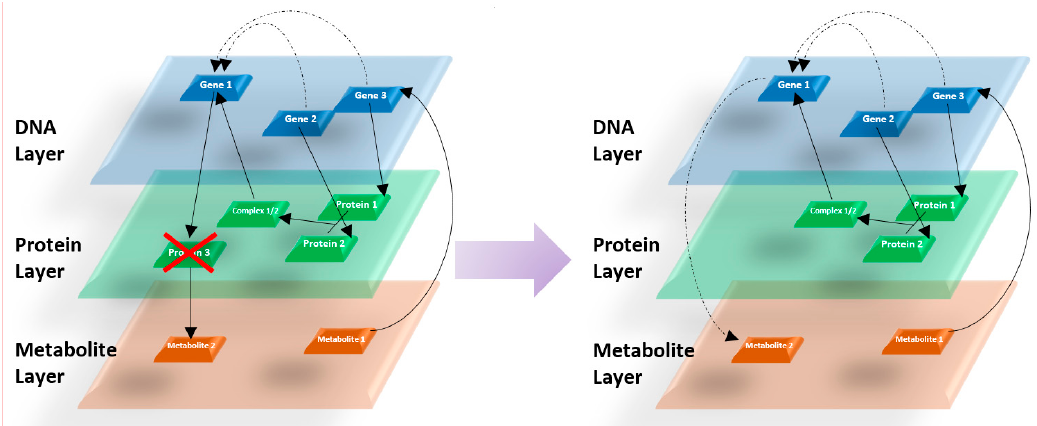
Figure 4. Addition of transitive edges after the deletion of a certain node.